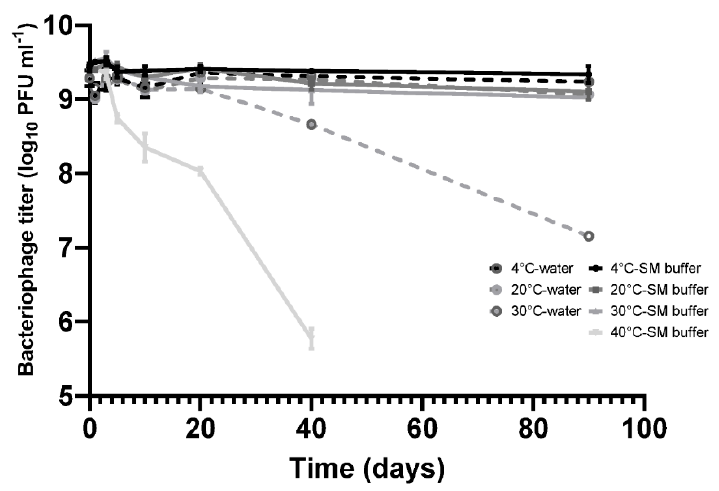
Figure 1. Stability of phage CP30A in RO (Reverse Osmosis) water and SM bu ff er (50 mM Tris.HCl (pH7.5), 100 mM NaCl, 8 mM MgSO4, 0.01% Gelatin). Samples were incubated in static incubators and aliquots were removed at each time point for phage titration. Error bars represent the standard deviation of the mean between three biological replicates.